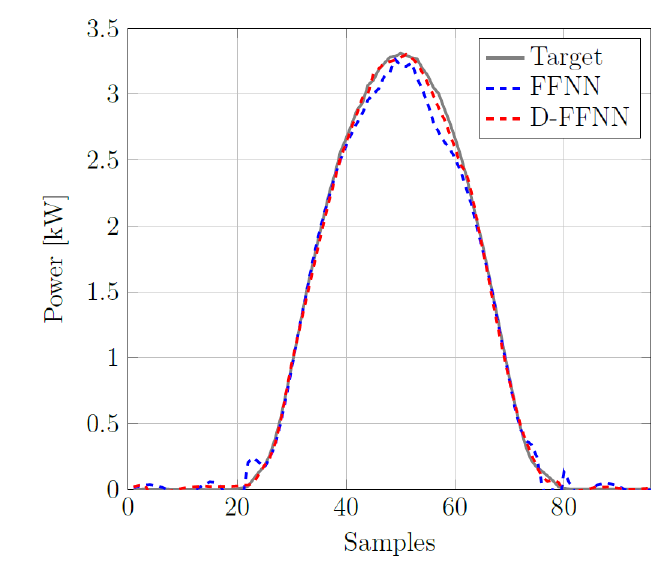
Figure 16. Prediction of a sunny day, 7 July 2019: the continuous line indicates the real measurements and the discontinuous line refers to the D-FFNN predicted values.